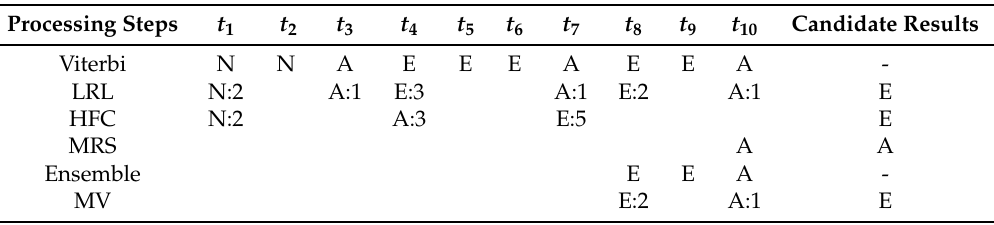
Table 1. Illustration of the algorithm with an example.